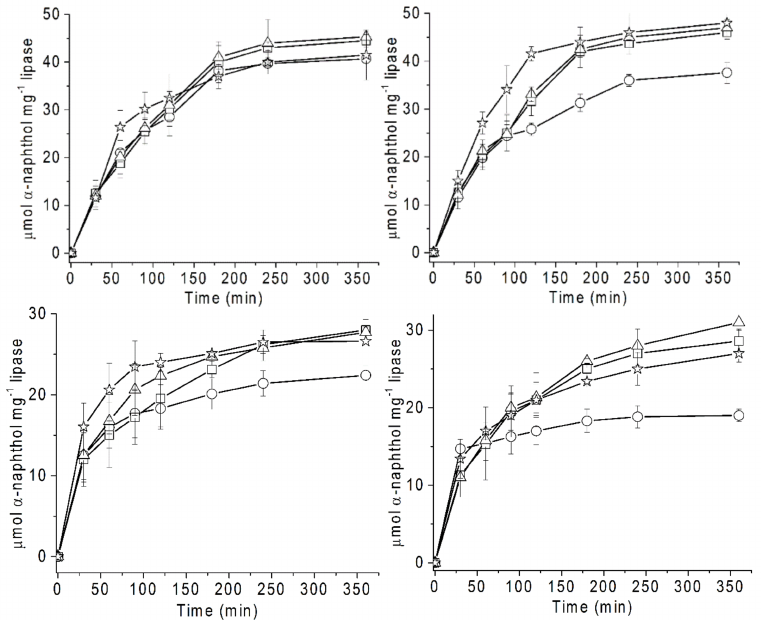
Figure 4. Productivity of unmodified and modified lipases from thermally-adapted lipases at different temperatures. Above, two figures: 50 ◦ C; below, two figures: 75 ◦ C. Left, two figures: Cold-adapted lipase from Candida antarctica ; right, two figures: Mesophilic Humicola lanuginose . Circle: Native; square: Benzoic anhydride-modified enzymes; triangle: Polyethylene glycol-modified enzymes and star Ficoll-modified enzymes. All experiments were performed in triplicate and error bars are shown for each data point (reproduced from [18] with permission from